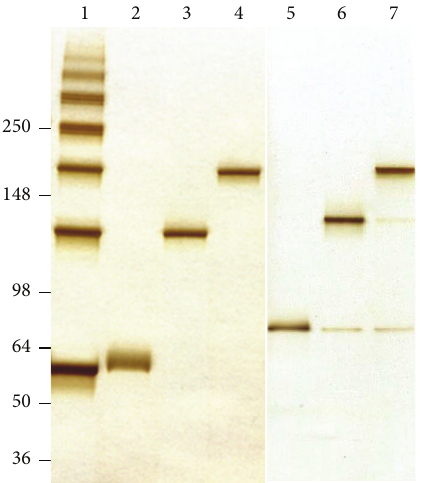
Figure 3: Recombinant human tau (rhTau) monomeric and oligomeric species production and purification. rhTau 1N4R enriched with disulfide-mediated tau oligomers (lane 1) was used for the purification of monomeric, dimeric, and trimeric tau species (lanes 2–4), 2N4R purified monomeric, dimeric, and trimeric species (lanes